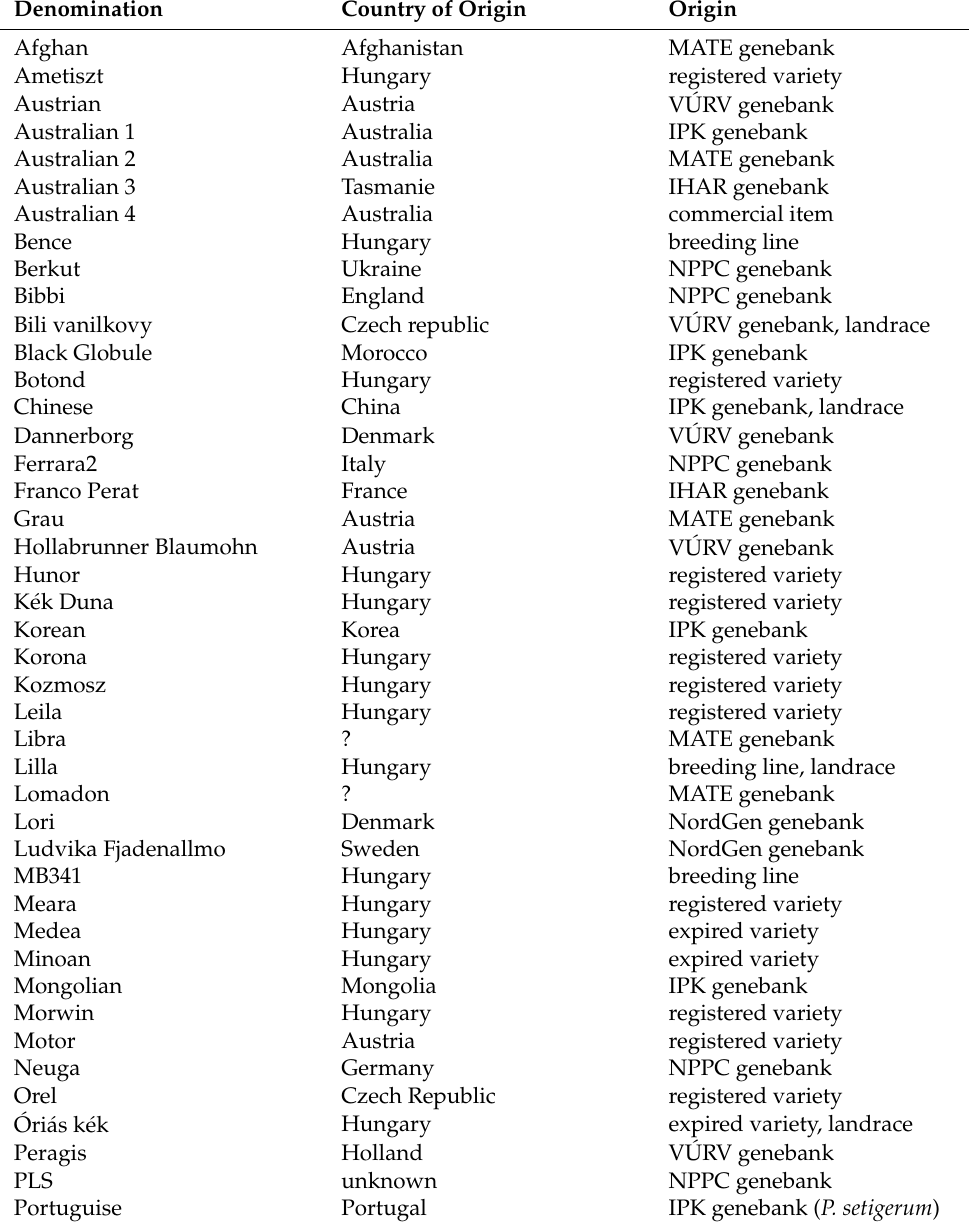
Table 1. Origin of the studied plant